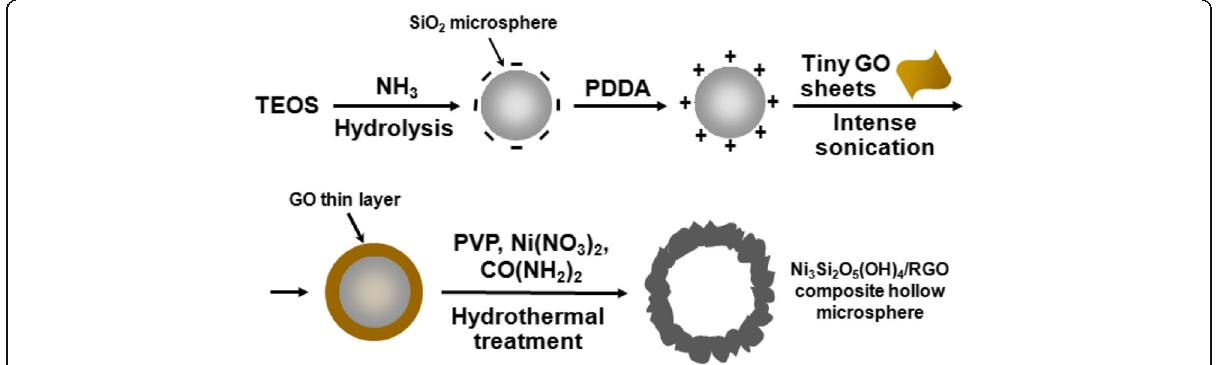
Fig. 1 Schematic representation of the fabrication of hierarchical flower-like Ni 3 Si 2 O 5 (OH) 4 /RGO composite hollow